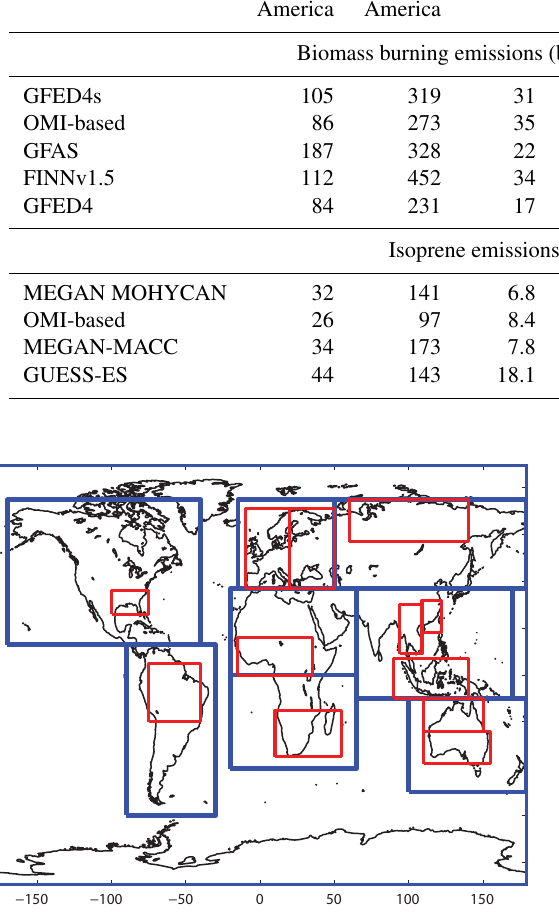
Figure 3. Definition of big and small regions used in this study. Big